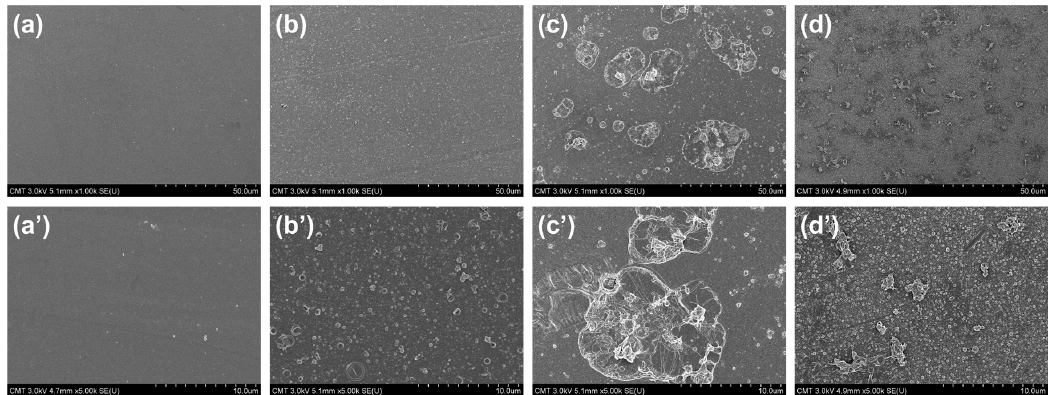
Figure 6. Surface field emission scanning electron microscopy (FESEM) images (magnification = ×1k and ×5k) of ( a , a’ ) PSf, ( b , b’ ) TFC, ( c , c’ ) TFN Na-MMT and ( d , d’ ) TFN O-MMT . Particle concentration = 0.05 g O-MMT/ g TMC.